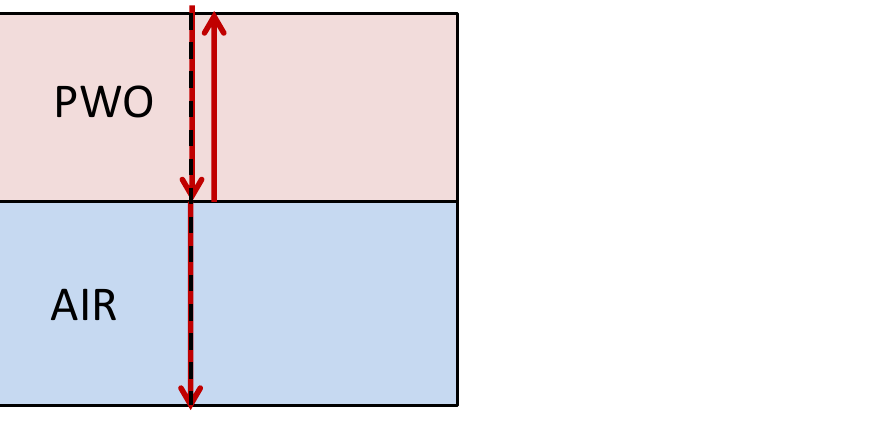
Figure 5. The wave path inside and outside (air) the sample. The wave, indicated by the red arrow, travels normally to the interfaces.